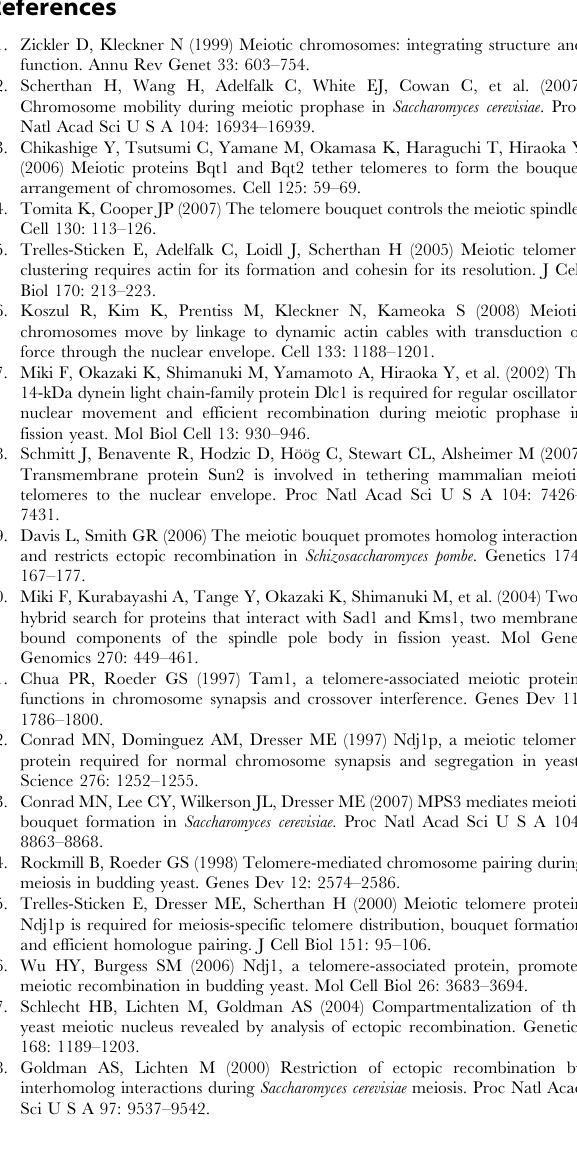
Figure S4 csm4 D confers a defect in meiotic progression that is suppressed by the rad17 D mutation. Synchronized meiotic cultures of WT (diamond, EAY1553), csm4 D (square, EAY1554), rad17 D (triangle, EAY2201) and csm4 D rad17 D (cross, EAY2202) were analyzed for the completion of at least MI (MI + MII) as measured by DAPI staining. A representative experiment is shown. Tetrads dissected from sporulated strains displayed the following percent spore viability: WT-93% (Figure 1), csm4 D -65% (Figure 1), rad17 D - 17% (175 tetrads dissected), and csm4 D rad17 D -1.1% (87 tetrads dissected). Found at: doi:10.1371/journal.pgen.1000188.s004 (0.07 MB TIF) Table S1 Strains used in this study. Found at: doi:10.1371/journal.pgen.1000188.s005 (0.1 MB DOC) Table S2 Genetic map distances (cM) and the distribution of parental and recombinant progeny for the NH942/NH943 strain background in WT and csm4 D on chromosomes III, VI, and, VIII. Found at: doi:10.1371/journal.pgen.1000188.s006 (0.1 MB DOC) Table S3 Interference as measured by the Malkova method. Found at: doi:10.1371/journal.pgen.1000188.s007 (0.2 MB DOC)